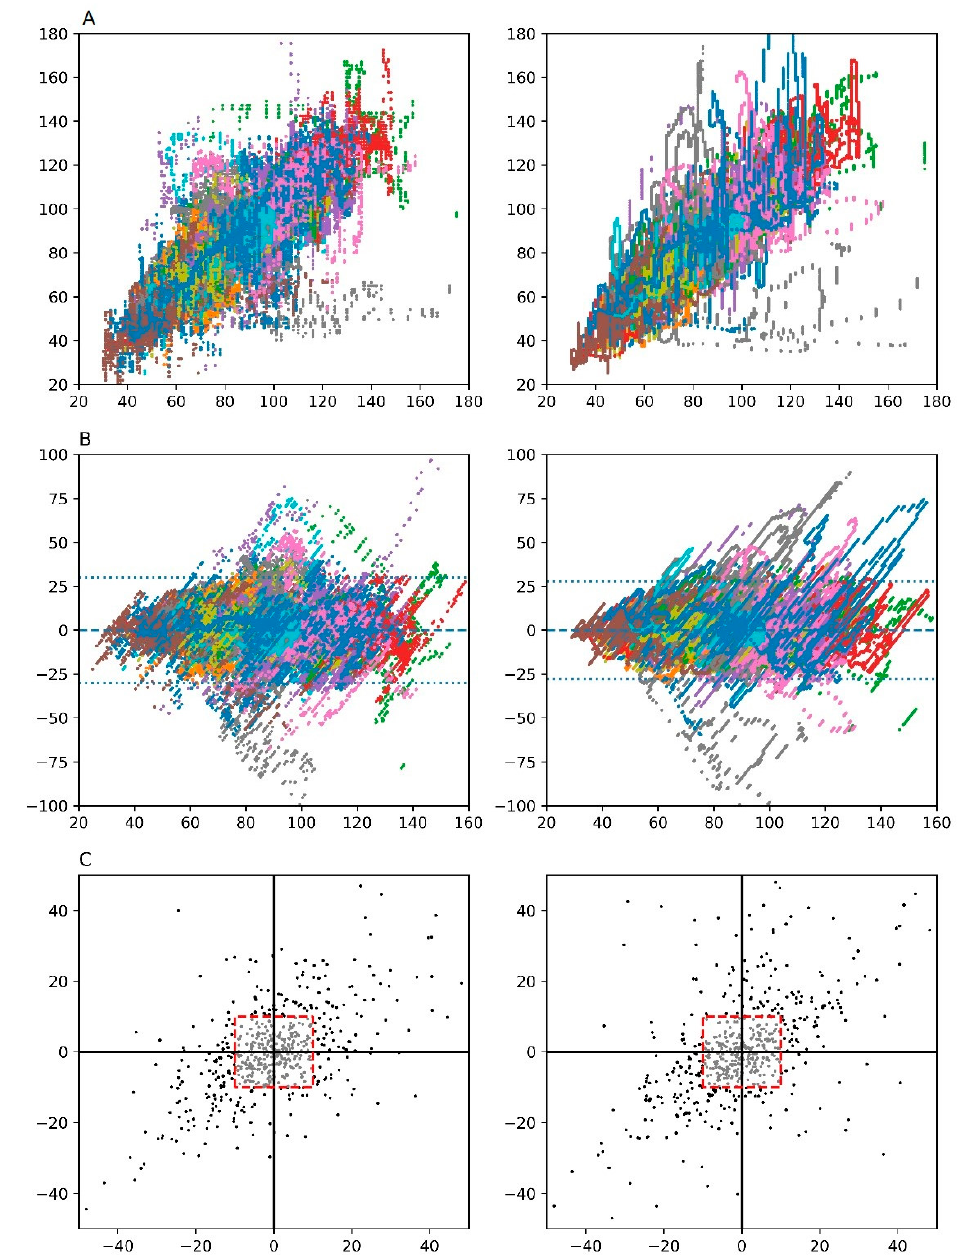
Figure 3. Scatter ( A ), Bland Altman ( B ) and Four-quadrant ( C ) plot analysis between the target stroke volume (SV) and predicted SV. Predicted SVs are EV1000 (left) and proposed model (right), respectively. Each color represents each cases. A central exclusion zone (red square) is shown in Four-quadrant plot.